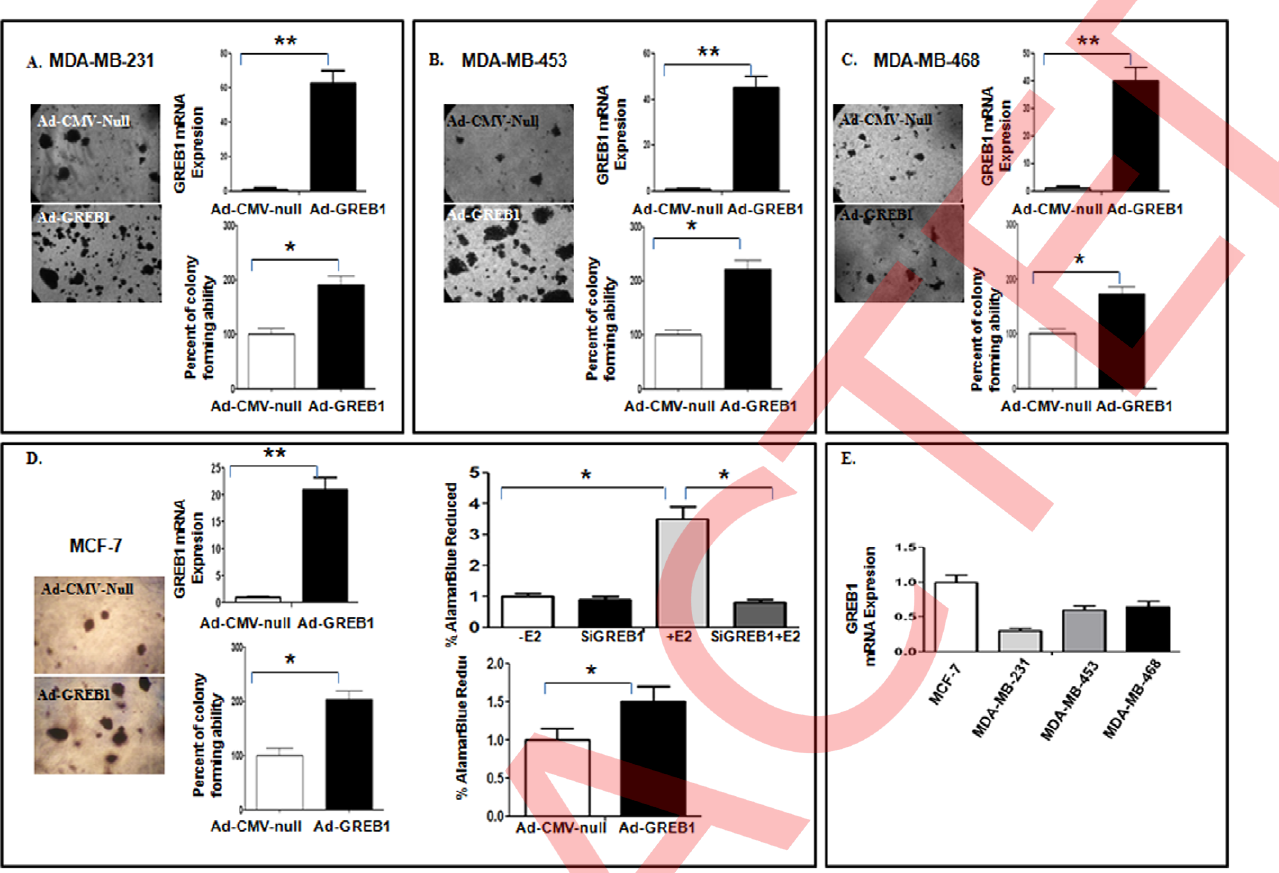
Figure 4. Overexpression of GREB1 promotes cell proliferation and increases the clonogenic ability of breast cancer cells. MDA-MB- 231, MDA-MB-453, MDA-MB-468 and estrogen depleted MCF-7 for 3 days were infected with Ad-CMV-null and Ad-GREB1 at an MOI of 10 respectively. The cells transduced with Ad-GREB1 expressed high GREB1 mRNA levels, whereas GREB1 was at extremely low detectable level in all cells including estrogen deprived MCF-7 asynchronous cultures (Figure 4D, middle upper panel), MDA-MB-231 (Figure 4A, right upper panel), MDA-MB-453 (Figure 4B, right upper panel), and MDA-MB-468 (Figure 4C, right upper panel) cell cultures transduced with empty vector. The soft agar assay was used as a measure of anchorage independent growth. The ability of MDA-MB-231 (Figure 4A, left panel), MDA-MB-453 (Figure 4B, left panel), MDA- MB-468 (Figure 4C, left panel), and MCF-7 (Figure 4D, middle lower panel) to grow in soft agar is substantially enhanced 1.9-, 2.2-, 1.7- and 2.0- fold following GREB1 transfection. We next tested E2 deprived MCF-7 cells for the effects of GREB1 on cell proliferation. The growth rate in MCF-7 cells treated with E2 is 3.5 fold higher than in estrogen depleted, quiescent controls. Transfection with the SiGREB1 had significant effect on cells treated with E2, as showed here that cell proliferation was completely abolished (Figure 4D, right upper panel). In MCF-7 cells transduced with Ad-GREB1, the metabolic activity as measured by AlamarBlue was also increased by 1.5 fold compared to Ad-CMV-null transfected controls (Figure 4D, right lower panel). The transfection efficiency in E2-deprived MCF-7 cells (21- fold in Figure 4D, middle upper panel) is a little lower than those of ER-negative cells such as MDA-MB-231 (63-fold in Figure 4A, right upper panel), MDA-MB-453 (45-fold in Figure 4B, right upper panel) and MDA-MB-468 (40-fold in Figure 4C, right upper panel). Figure 4E showed the little higher basic expression level of GREB1 in E2-deprived MCF-7 cells than other cells. Data are shown as mean 6 SD. * P , 0.05; ** P , 0.01.